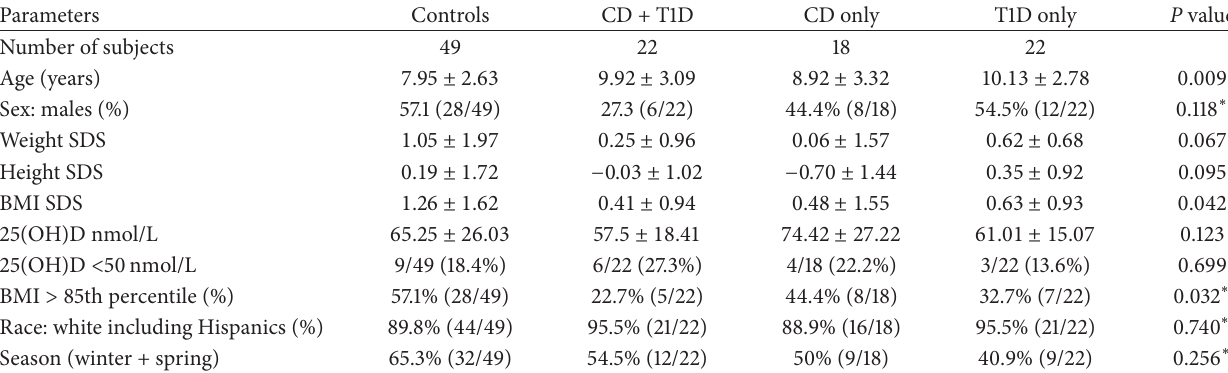
Table 1: A comparative analysis of the characteristics of the subjects and